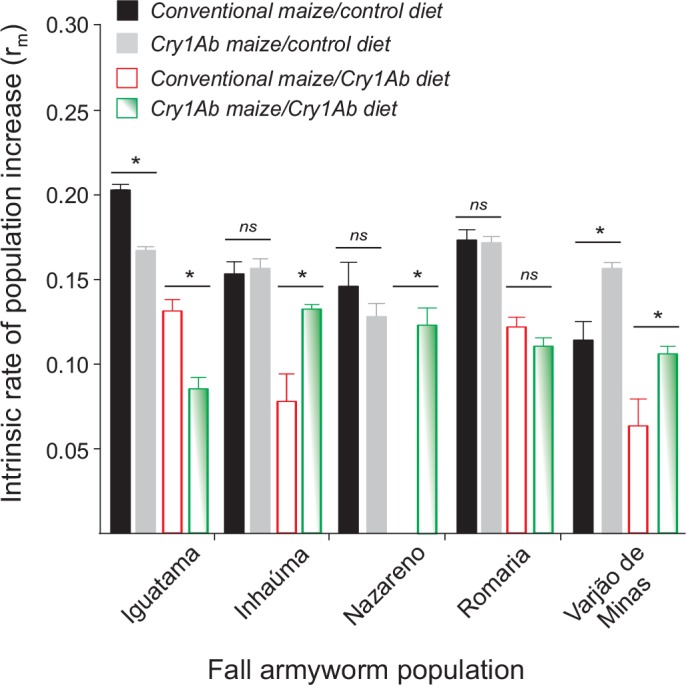
Fitness index for five Spodoptera frugiperda populations exposed to Bt Cry1Ab maize.Insects were collected from conventional non-Bt or Cry1Ab maize fields and their progeny were reared on leaves of non-Bt isoline (i.e. control diet) or Cry1Ab maize foliage (i.e., Cry1Ab diet) in the laboratory. Data are estimates of intrinsic rate of population growth obtained using the life table format, and error bars are 95% confidence intervals. While asterisk indicates significant difference (P < 0.05) by one-tailed t-test using variances estimated by the jackknife technique in SAS [42], ns indicate no significant difference.